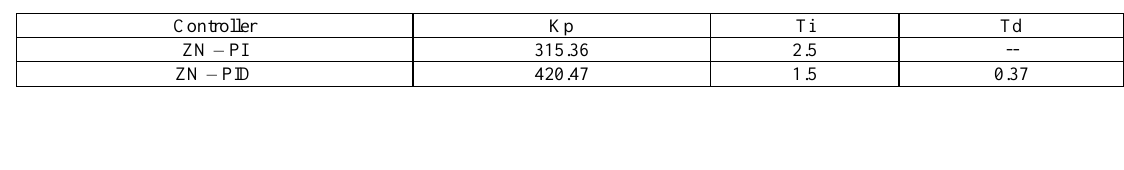
Table 2. TL tuning